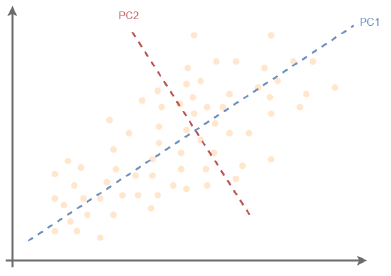
Figure 11. Representation of the principal component analysis